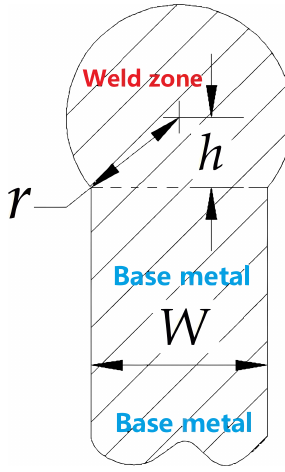
Figure 1. Cross section morphology after single